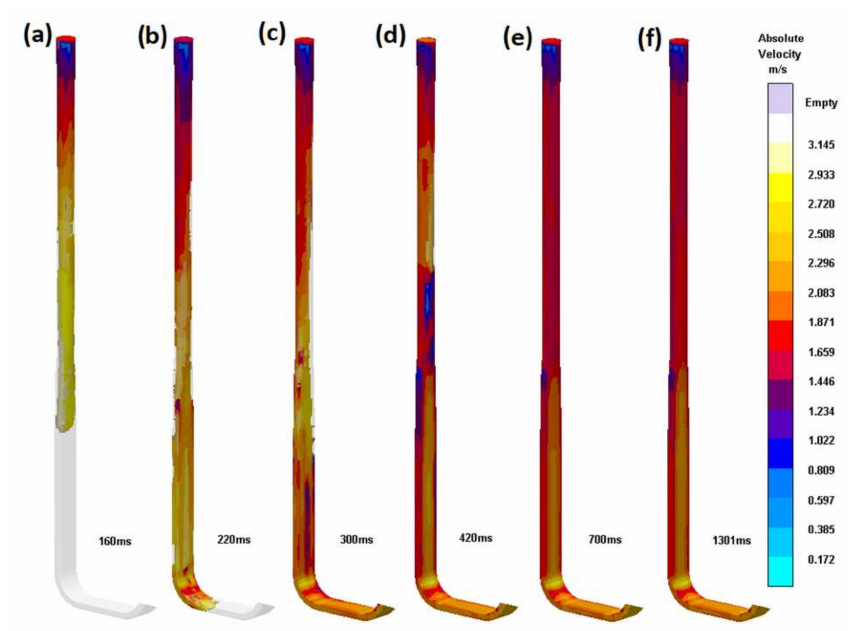
Figure 13. Transitional sprue with improper transition (S i 5). Subsequent stages of the flow ( a ) 160 ms,